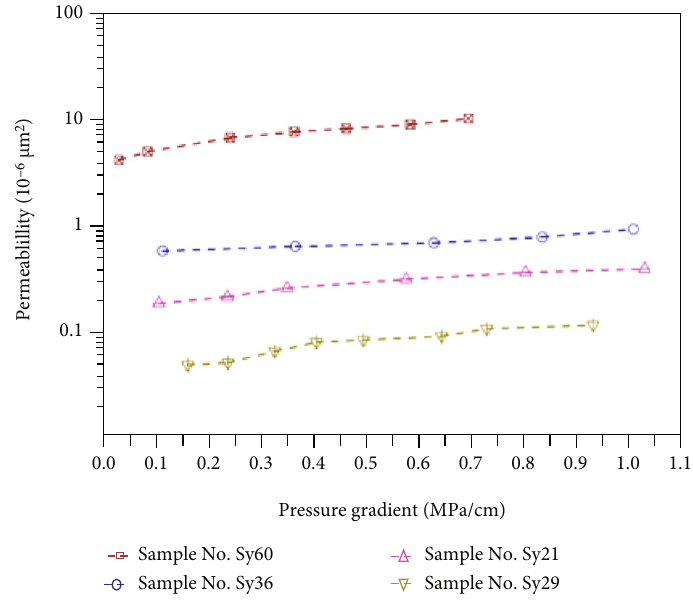
Figure 9: Plot of the oil phase permeability vs. pressure gradient. The permeability increases as the pressure gradient increases.